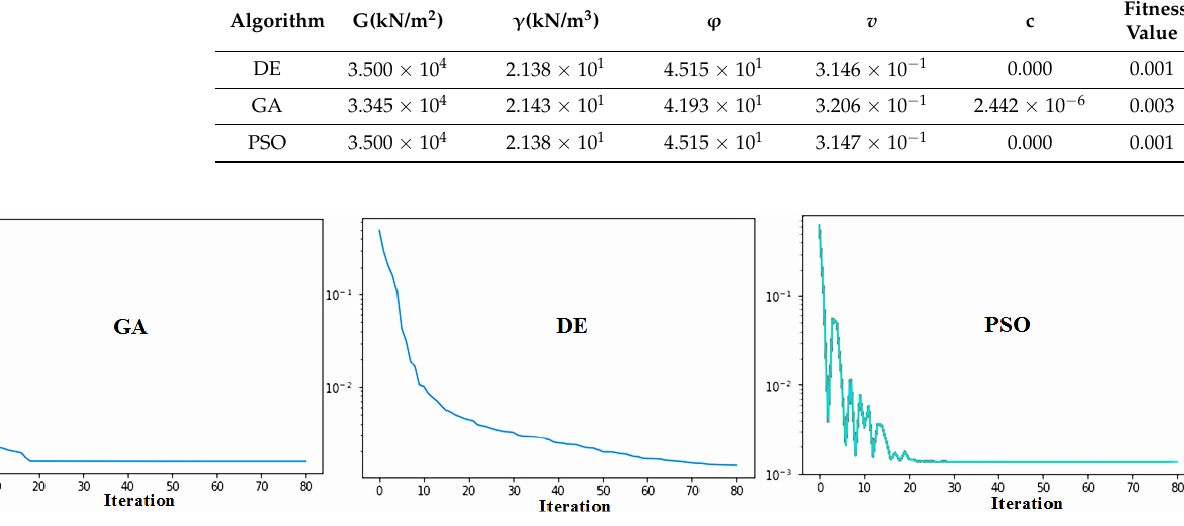
Figure 10. Convergences observed in the analysis using three different algorithms: the GA, DE, and the PSO. Table 3. Values obtained using three different algorithms for the parameters in zone P using the inverse analysis procedure. The fitness value is the error function calculated for the entire popula- tion.